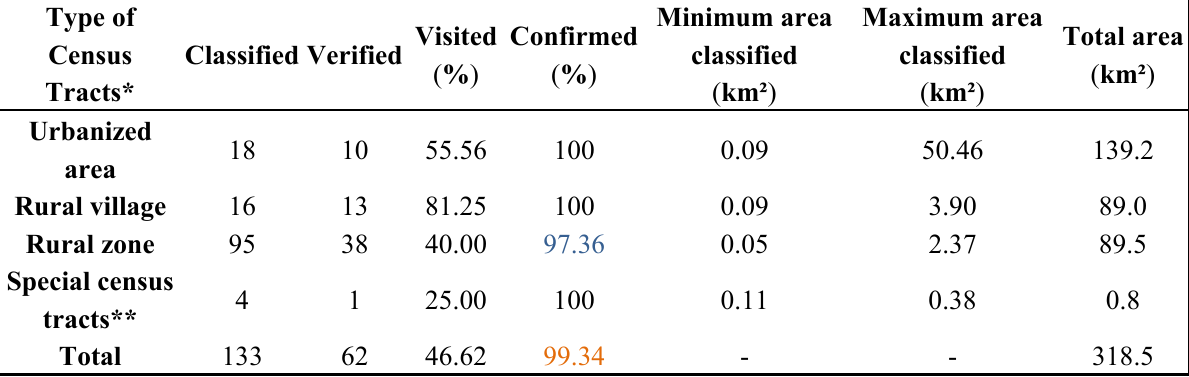
Table 4. Spatial units of human occupation classified from remote sensing and verified during